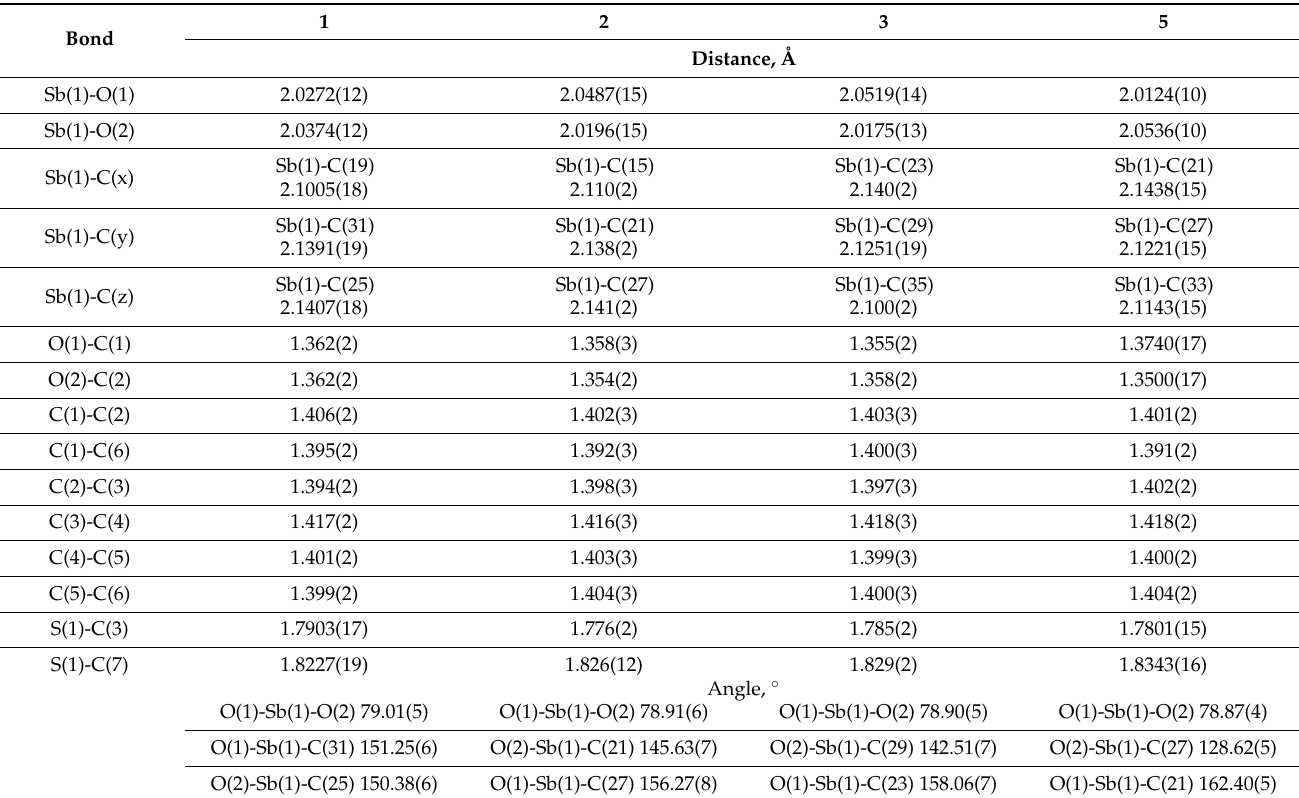
Figure 4. The X-ray structure of (3-cycloHexS-4,6-Cat)SbPh 3 ( 5 ). Hydrogen atoms are omitted, ellipsoids of 30% probability. Figure 4. The X ‐ ray structure of (3 ‐ cycloHexS ‐ 4,6 ‐ Cat)SbPh 3 ( 5 ). Hydrogen atoms are omitted, el ‐ lipsoids of 30% probability. Table 1. The selected bond lengths and valence angles in catecholates 1–3 , 5